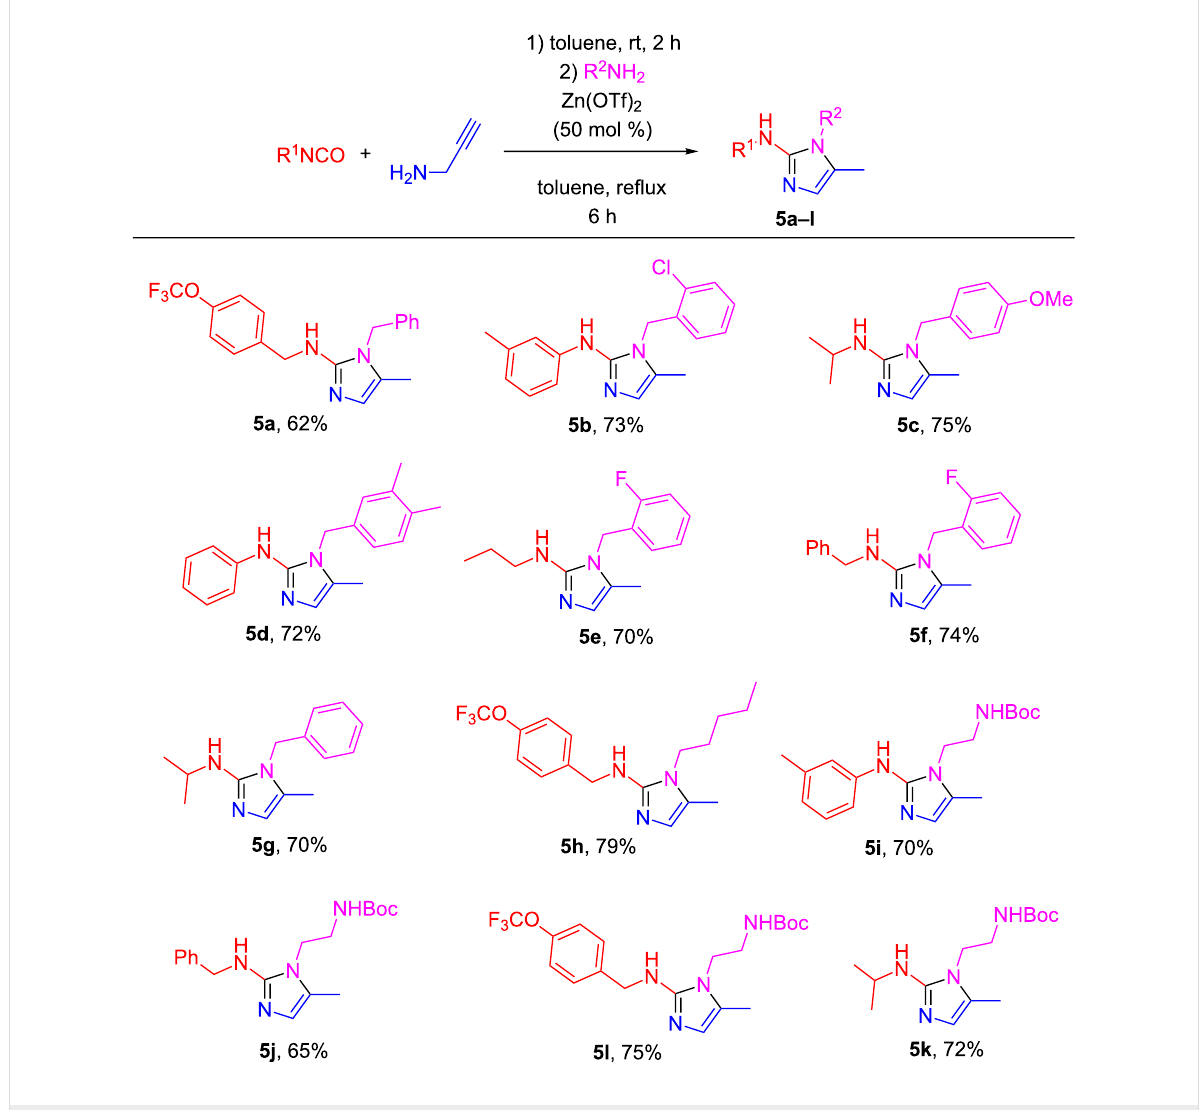
Figure 2: Substrate scope for the three-component synthesis of 5 .